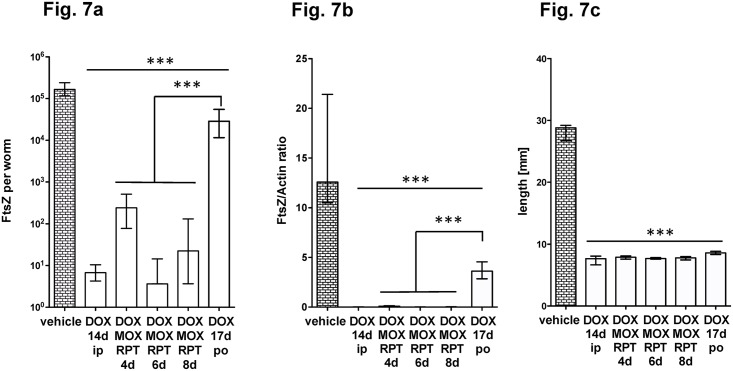
Oral administration of antibiotic/rifamycin/moxifloxacin triple-combinations for Wolbachia depletion.Antibiotics and rifamycins were administered ip at 50 mg/kg and moxifloxacin at 200 mg/kg/bid. Worms were recovered at day 35 post infection. Worms were recovered at day 35 post infection. FtsZ copy numbers (a) and the FtsZ/Actin ratio (b) are given per single female worm DNA extract. The female worm length is shown in (c). Significances were tested with MW-U test, a p-value of 0.05 was considered significant and exact p-values are given in S1 Table.